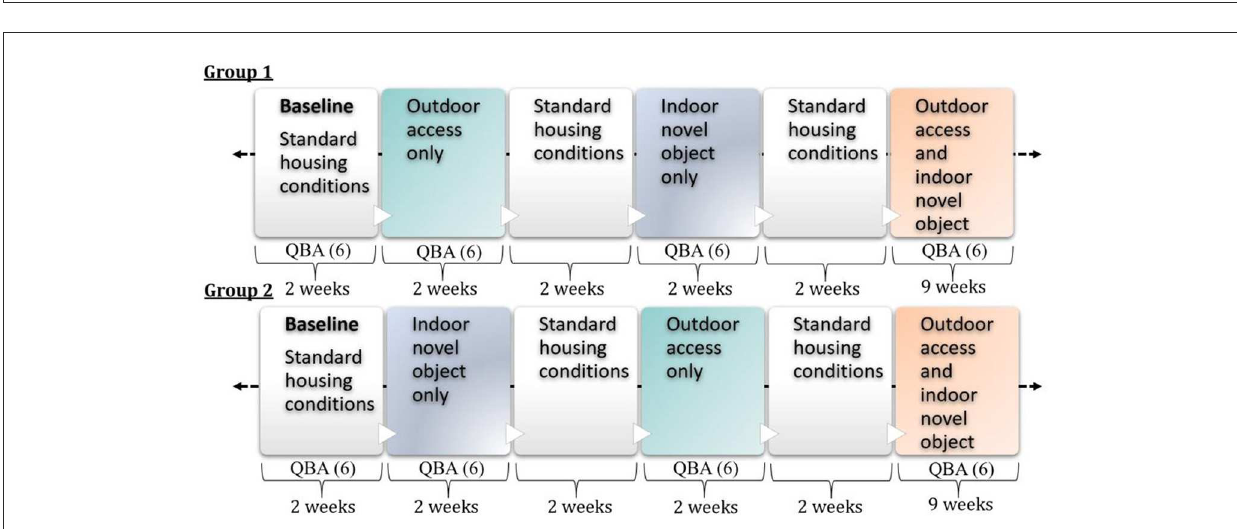
FIGURE3 Timeline of the six consecutive treatment periods of the trial, displaying the length of time of each housing modification. Housing alterations were made on Mondays. The number of Qualitative Behavioural Assessments (QBA) that were conducted is displayed under each treatment